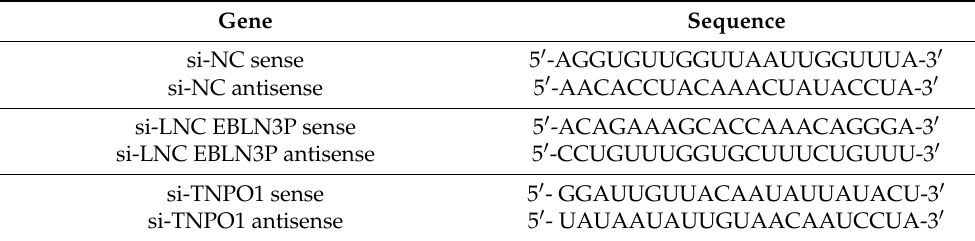
Table 1. Oligonucleotide siRNA sequences.